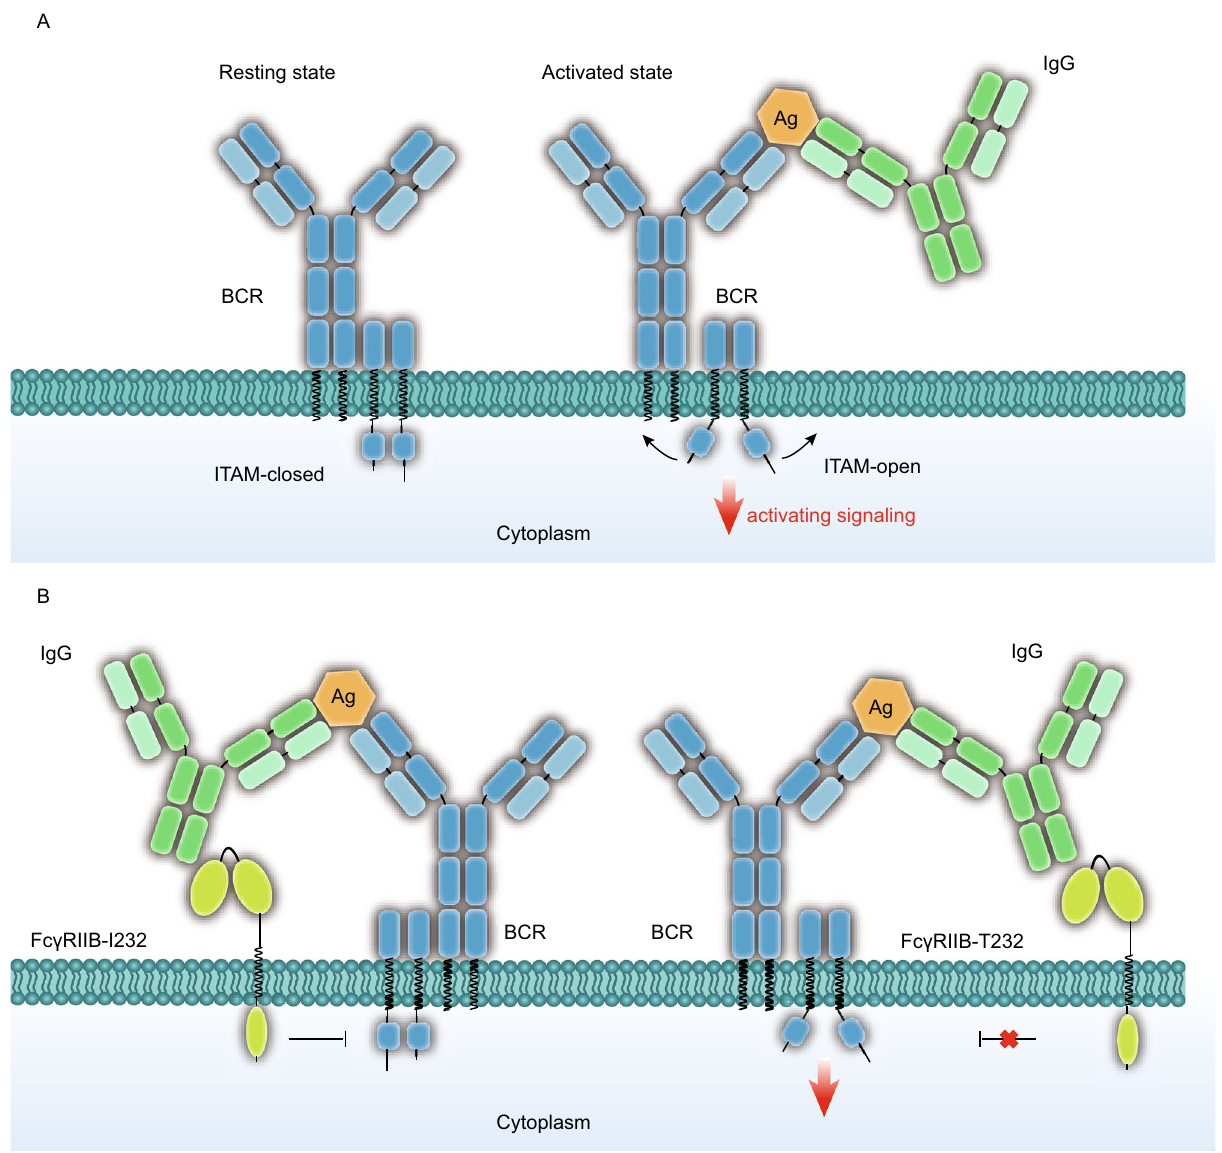
Figure 1. A conformational change blocking model. (A) Shown are the “ close to open ” conformational changes within the cytoplasmic tail of BCR during the cross-membrane signal transduction. (B) Fc γ RIIB-I232 blocks such conformational changes in the cytoplasmic domains of BCR, whereas Fc γ RIIB-T232 fails to do